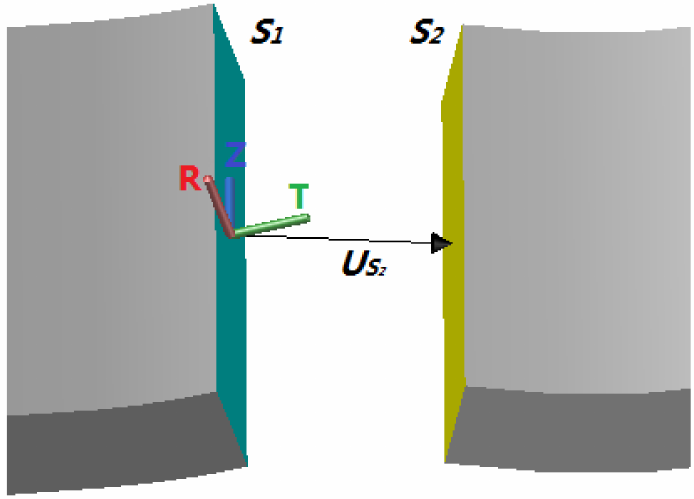
Figure 6. Motion of the interface.